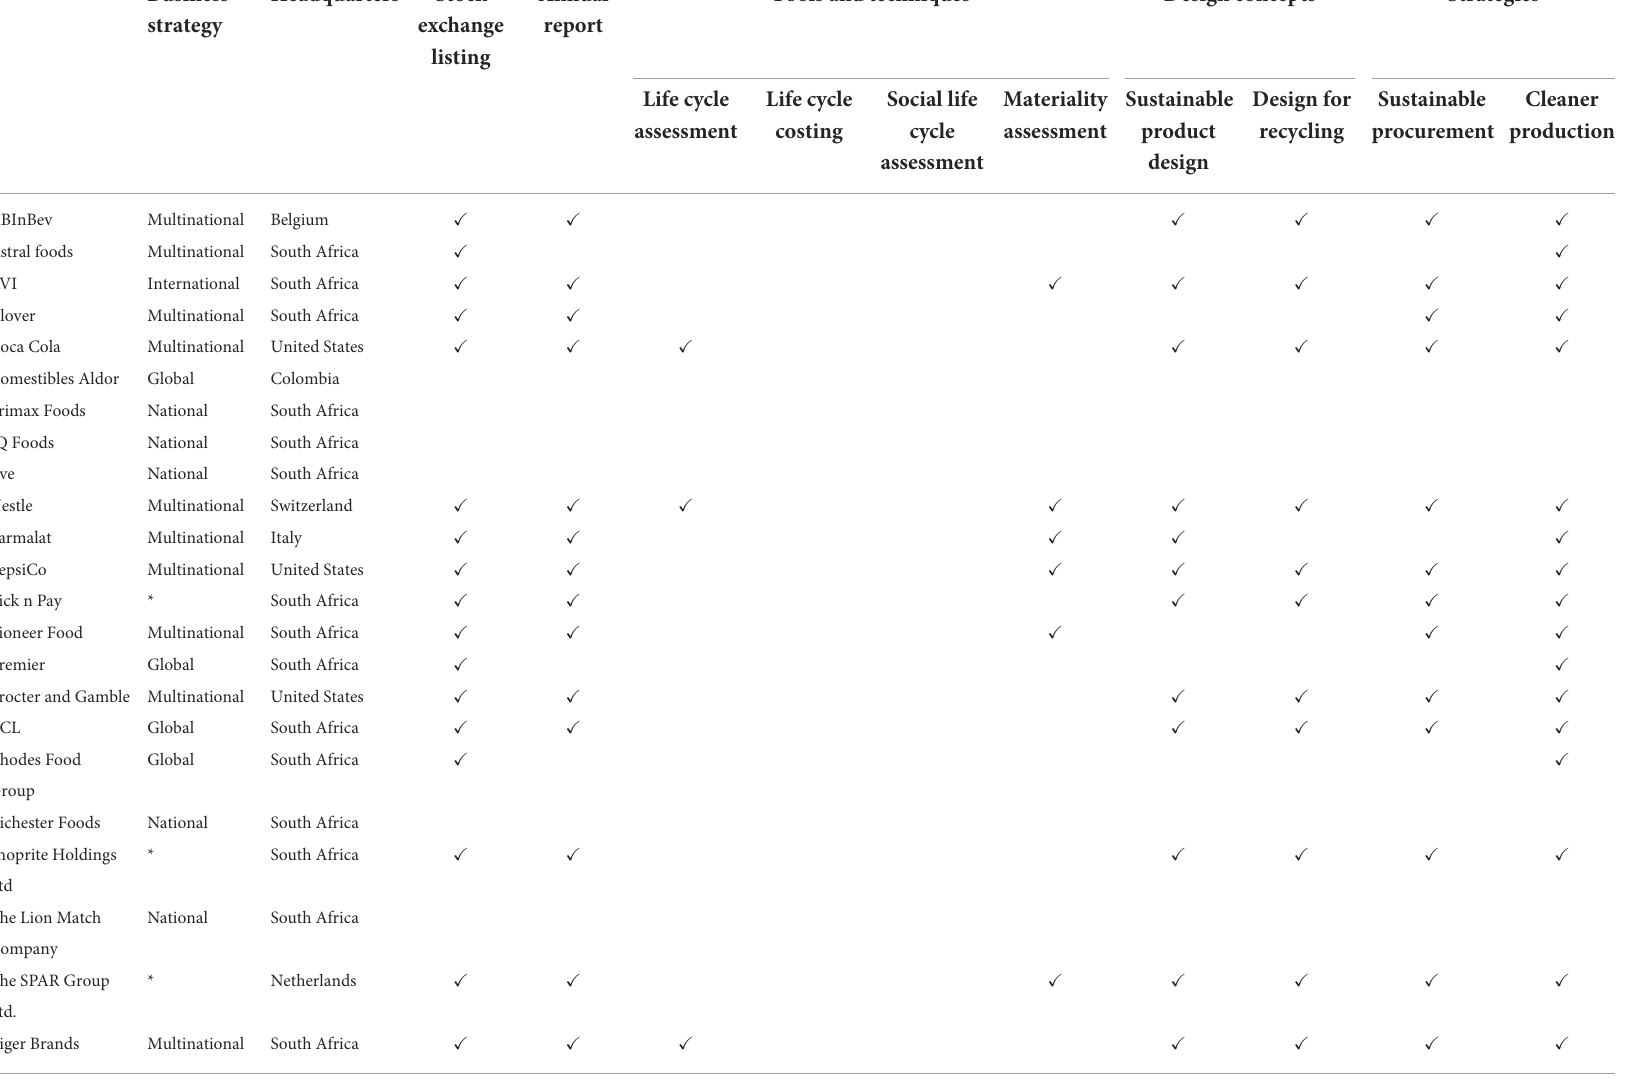
TABLE 4 LCM concepts, strategies, tools, and techniques employed by companies in South Africa in